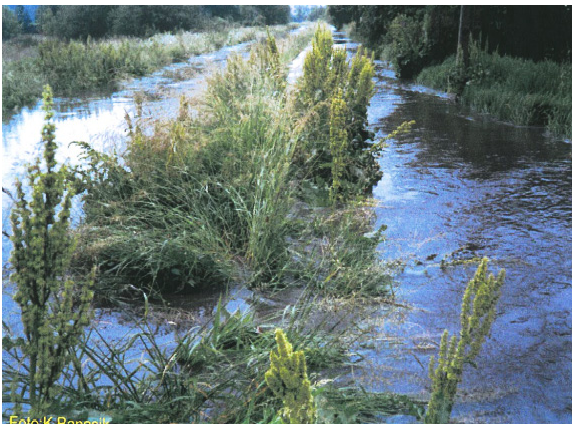
Figure A5. Discharge of water from the banks of the stream (onto the left bank) along Przy Grobli St. (towards the junction with the Wolica Canal) (K. Banasik).